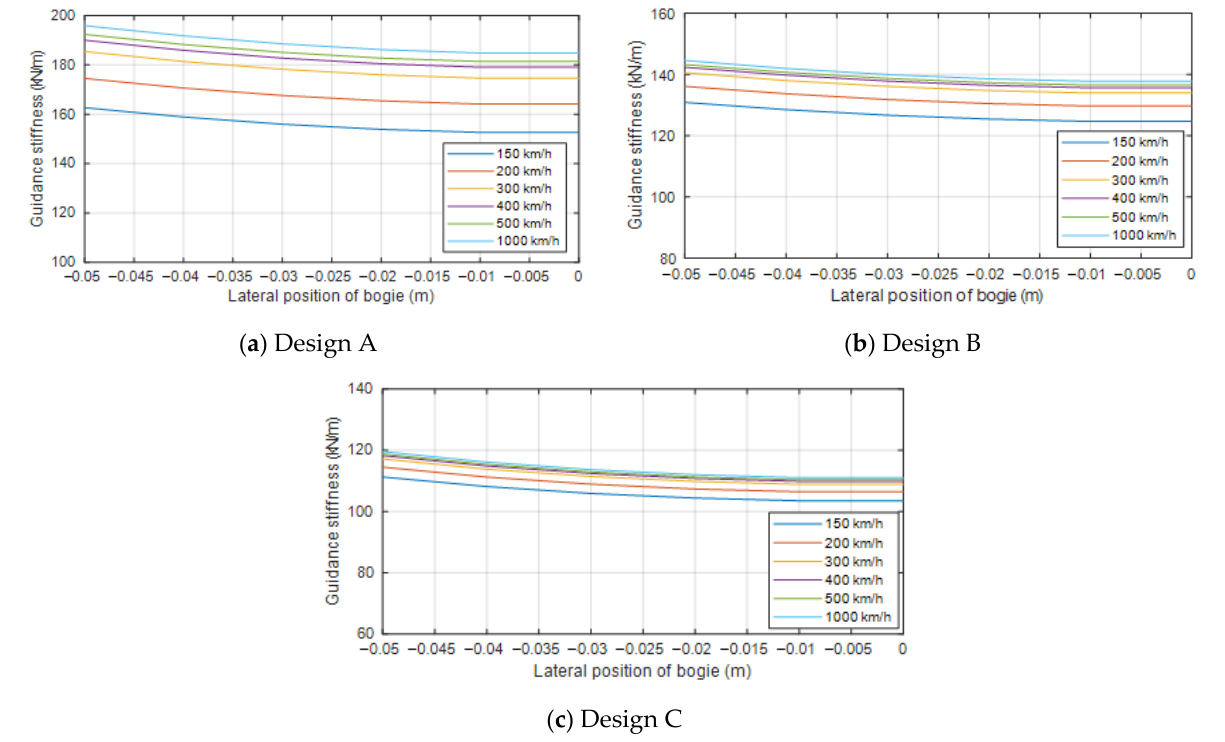
Figure 12. Relationship between guidance stiffness and lateral position (average).